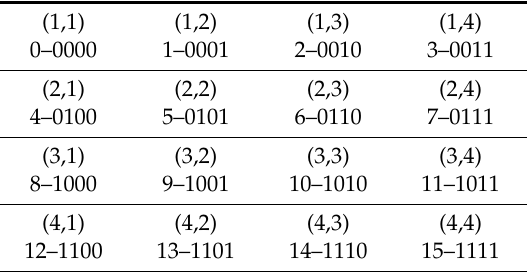
Table 2. Values used for each matrix position that select the output to be